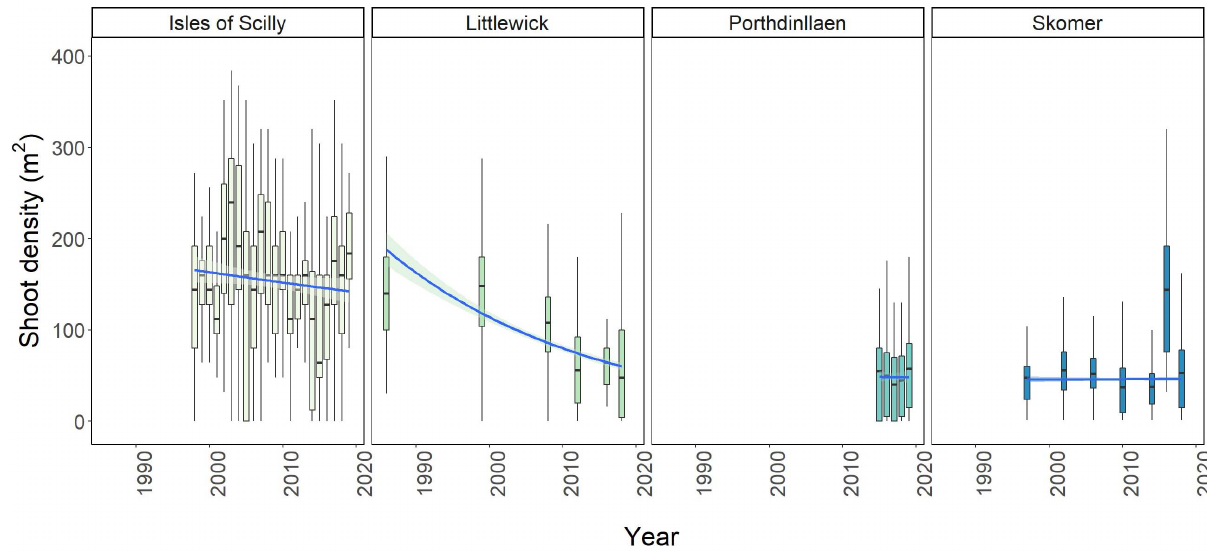
FIGURE 4 | Boxplots showing change in average shoot density per m 2 over time for Littlewick, Skomer, Porthdinllaen, and Isles of Scilly. The box-whisker represents the median (line) and interquartile range (box) with additional 1.5 × interquartile range shown as whiskers. Outliers not shown for clarity (data provided by NRW, Project Seagrass and Natural England respectively, with data from this study included for Skomer and